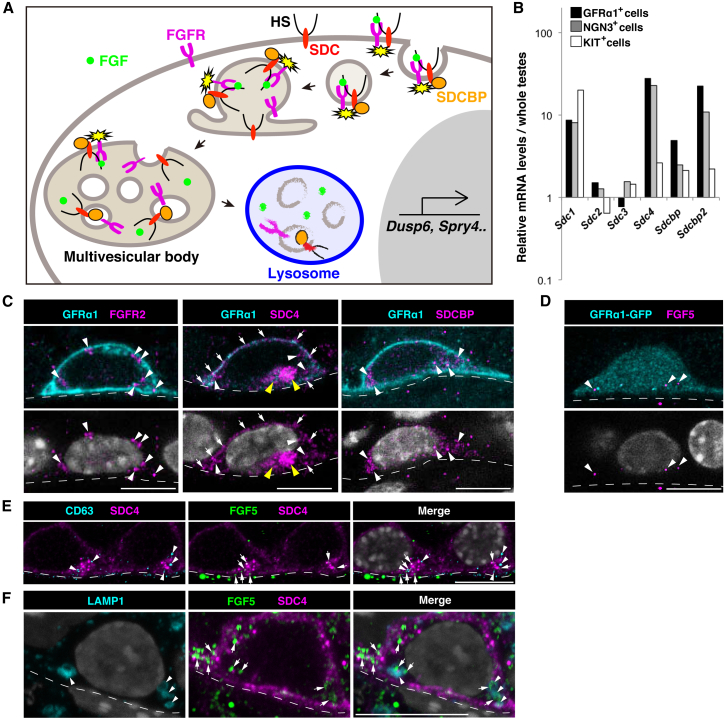
GFRα1+ Spermatogonia Uptake and Consume FGF5(A) A general scheme of FGF reception on target cells, adopted from Hanson and Cashikar (2012). (Republished with permission of Annual Reviews, from Multivesicular Body Morphogenesis, Phyllis I. Hanson and Anil Cashikar, volume 28, 2012; permission conveyed through Copyright Clearance Center, Inc.)(B) Expression of genes indicated in GFRα1+, NGN3+, and KIT+ spermatogonial fractions, selected from published cDNA microarray data (Ikami et al., 2015), and normalized to the values from the whole testis.(C and D) Representative images of GFRα1+ or GFRα1-GFP+ (cyan) cells exhibiting the speckled cytoplasmic staining of FGFR2, SDC4, SDCBP (C), or FGF5 (D) (magenta, white arrowheads) and cell surface SDC4 staining (white arrows). Cytoplasmic SDC4 signals often form prominent clusters (yellow arrowheads).(E and F) Representative images of SDC4+ (magenta) cells co-stained for FGF5 (green) with CD63 (E) or LAMP1 (F; cyan). FGF5+ speckles (arrows) were often co-localized with CD63+ (arrowheads) or LAMP1+ (arrowheads) foci in SDC4+ cytoplasmic clamp. Scale bars indicate 10 µm, and the broken lines show outlines of the tubules in (C)–(F).